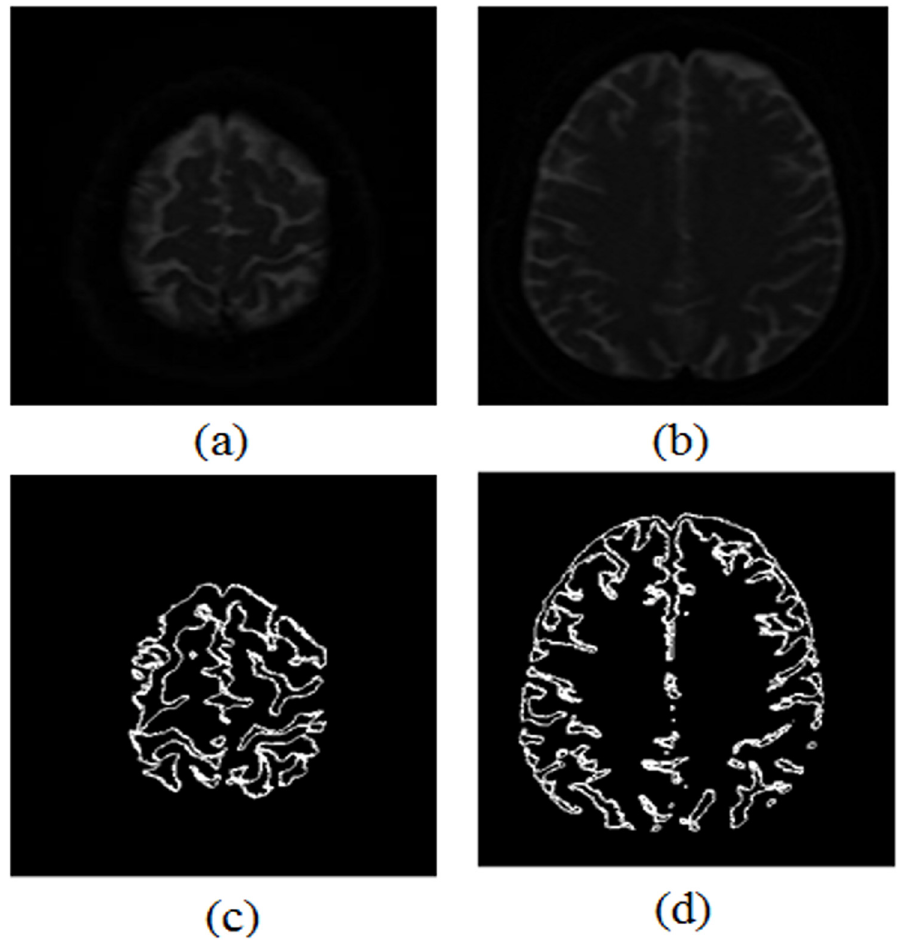
Fig 11. The results of the developed edge detection technique: (a) Greyscale clinical image 1, (b) Greyscale clinical image 2, (c) Edge detection in clinical image1, and (d) Edge detection in clinical image